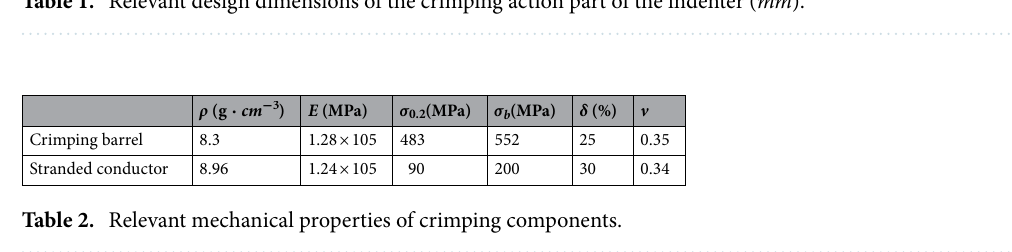
Table 1. Relevant design dimensions of the crimping action part of the indenter ( mm ).